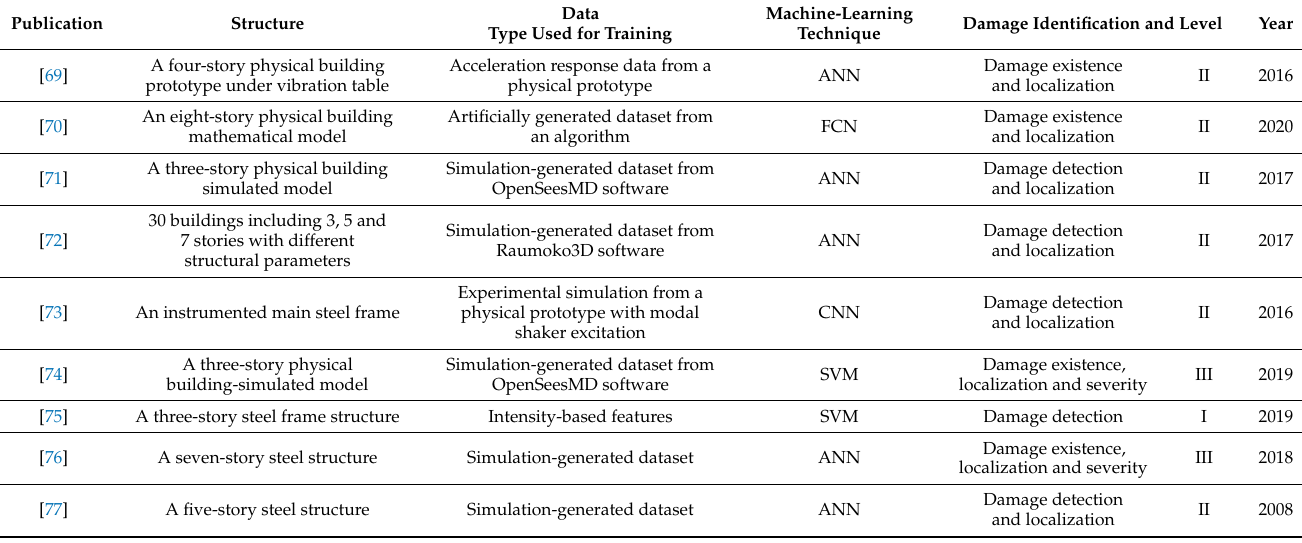
Table 7. N-story building structure health monitoring systems based on machine-learning